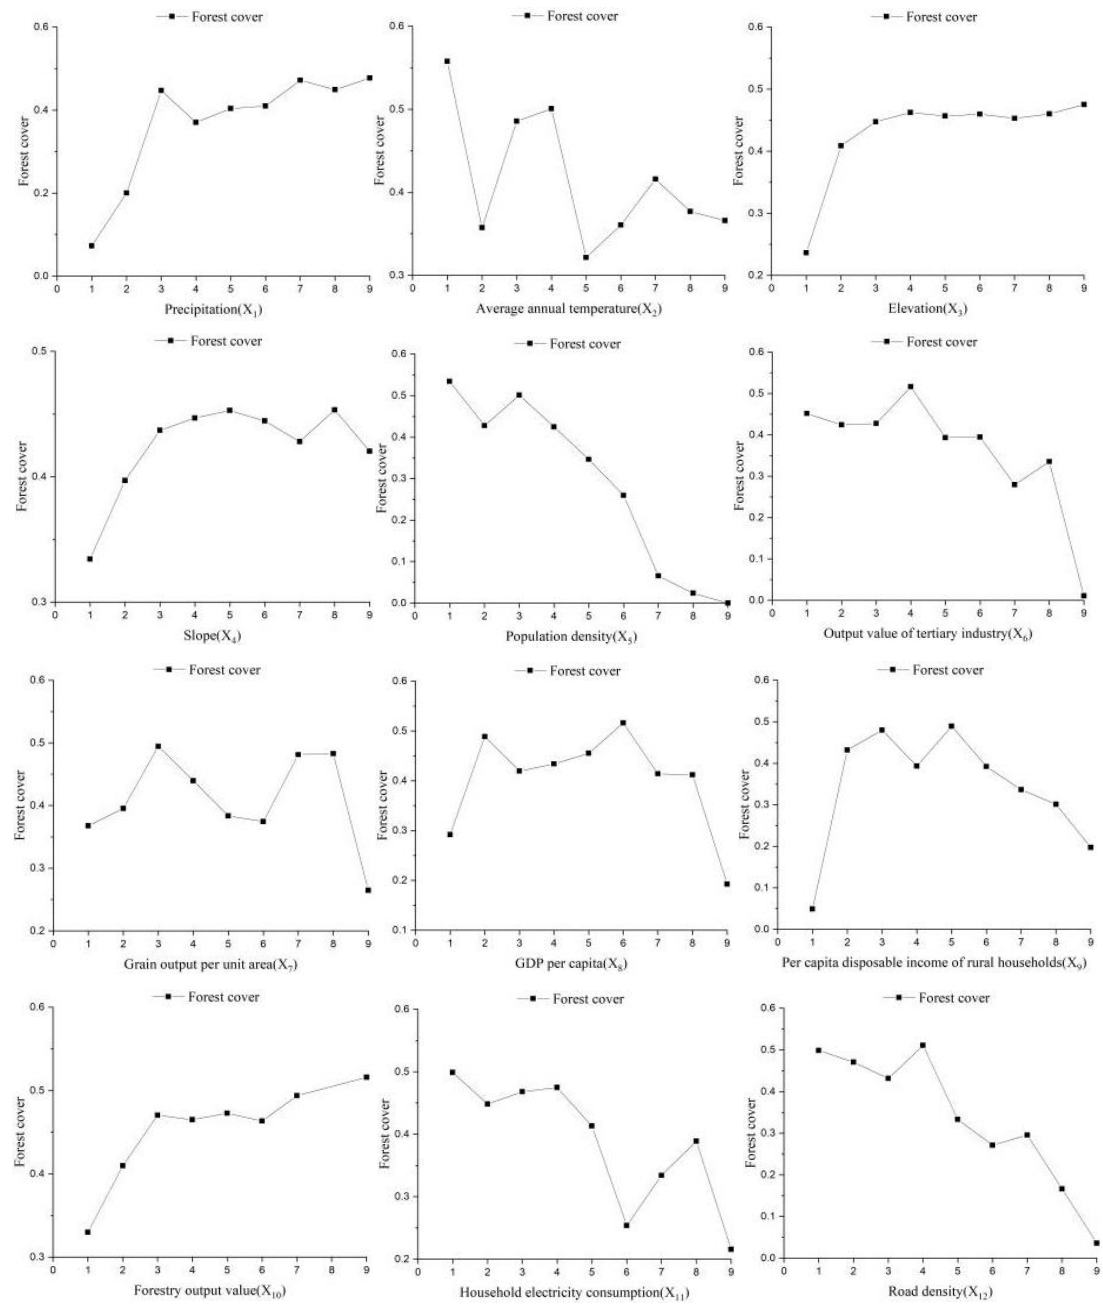
Figure 3. Results of risk detector for the spatial distribution of forest cover in Fujian Province.